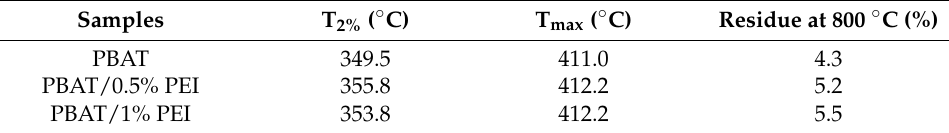
Table 5. TG and DTG results of PBAT and PBAT/PEI films.